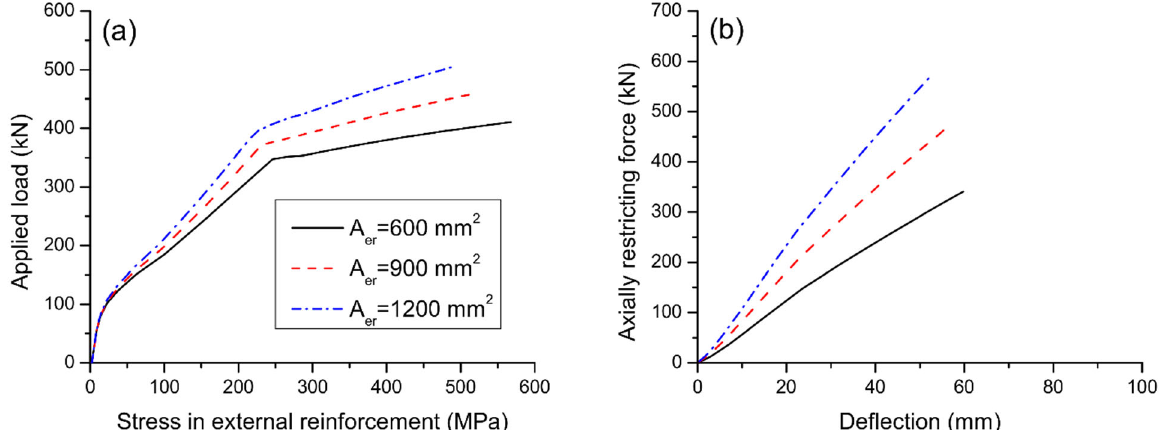
Figure 11. Effect of reinforcement area on the behavior of external reinforcement. ( a ) load versus reinforcement stress; ( b ) axially restricting force versus midspan deflection.